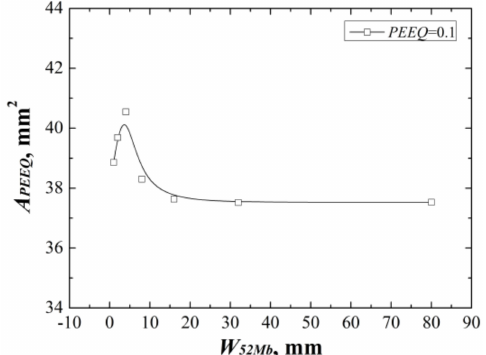
Figure 9. The areas surround by the ε p = 0.1 isoline at the same J -integral for “123” model.